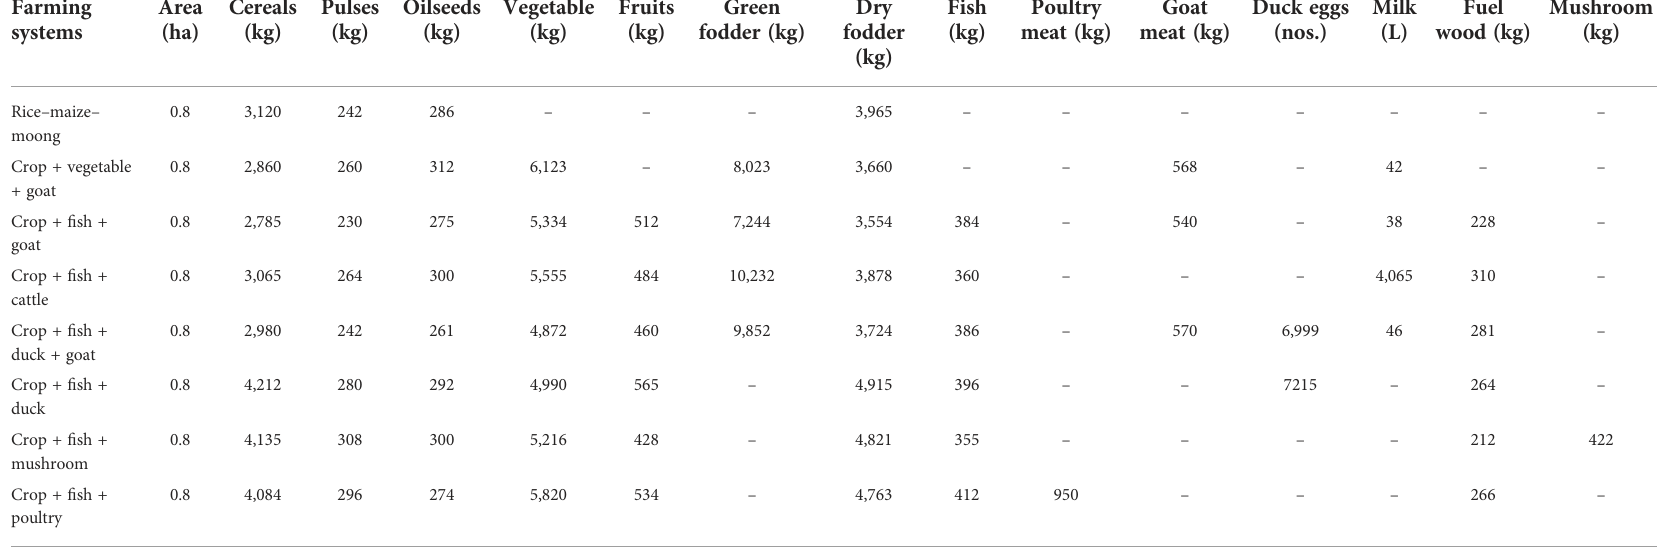
TABLE 11 Food and nutritional security as provided by different integrations (2016 –